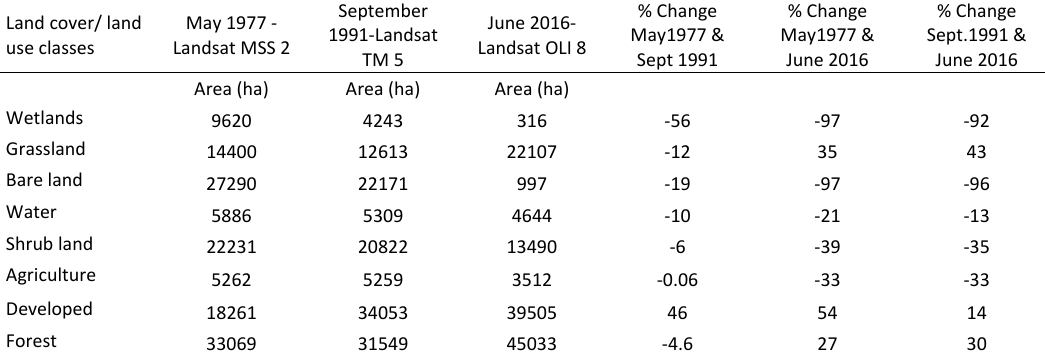
0510152025303540 Fig. 6: Percent cover of land cover/ land use categories in Davidson County for the years 1977, 1991 and 2016 Table 3: Change in the extent of land cover/ land use classes in Davidson County, Tennessee Land cover/ land use classes